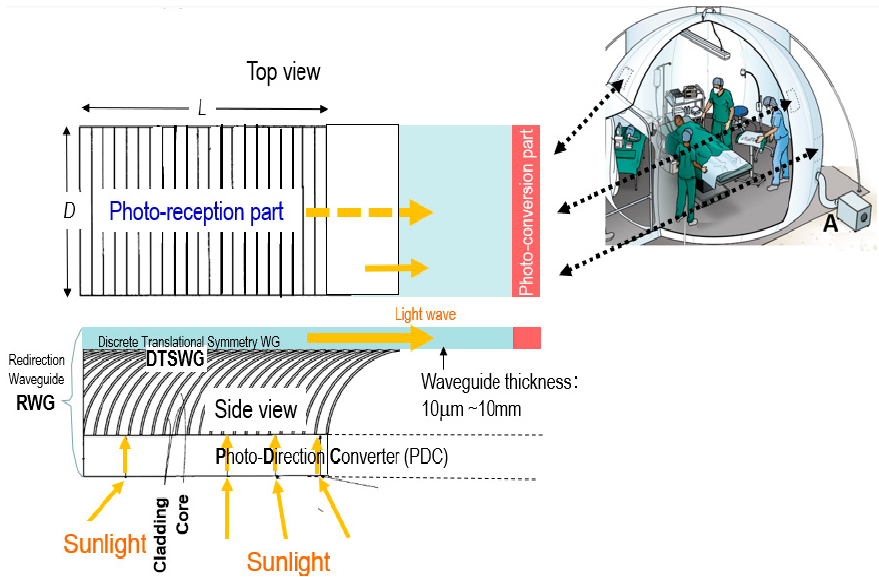
Figure 1. The target structure based on 2-Dimensional PhotoRecepto-Conversion Scheme (2DPRCS) coupled with Clean Unit System Platform (CUSP). The top right inset is an example of a compact clean system called bubble operating theater (BOT) Ref. [2] on which surface, as indicated by thick dotted arrows, we propose to put 2DPRCS-based solar cells as the power supply. In the middle is top view of a planar concentrator solar cell utilizing 2DPRCS. The side view or cross-sectional view is shown bottom left. The box denoted by “A” in the top right inset is air conditioner.